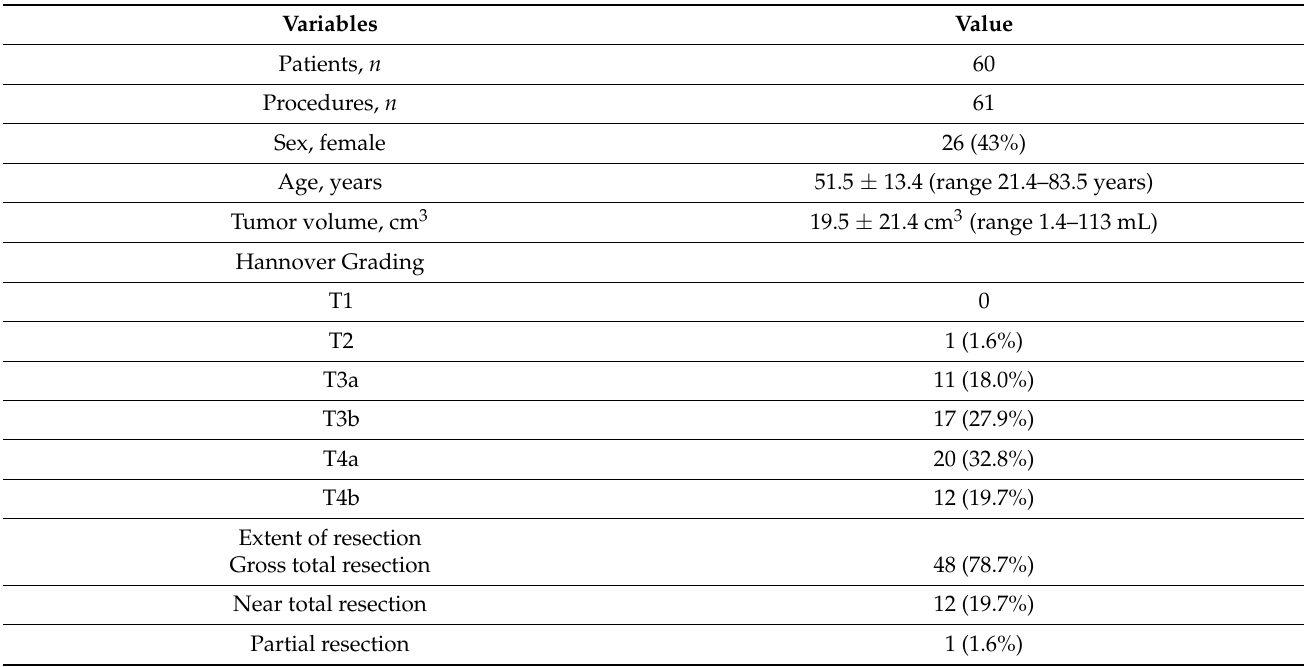
Table 2. Patient characteristics.